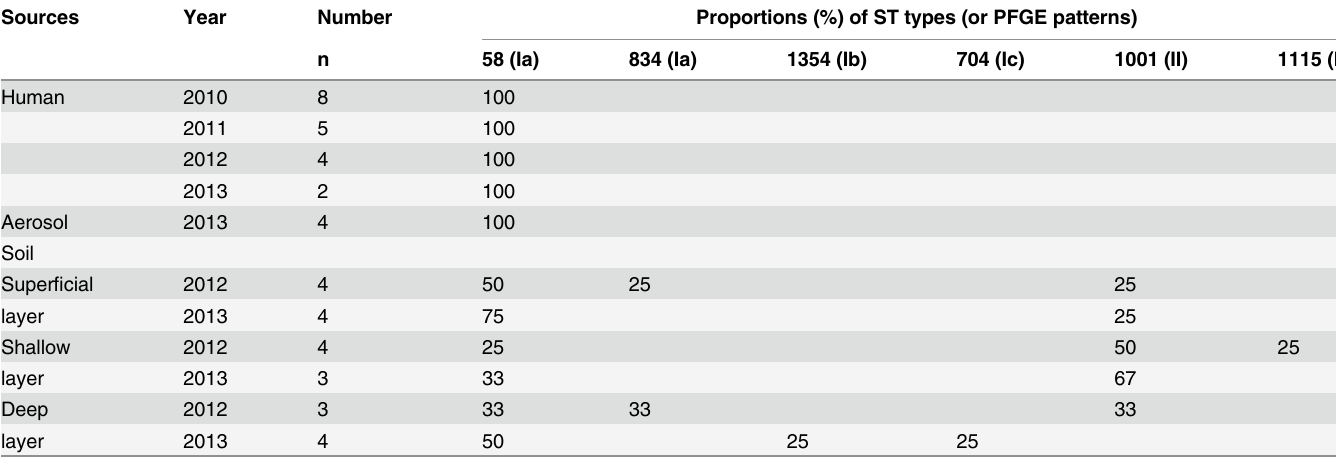
Table 3. Summary of ST types and PFGE patterns of B. pseudomallei